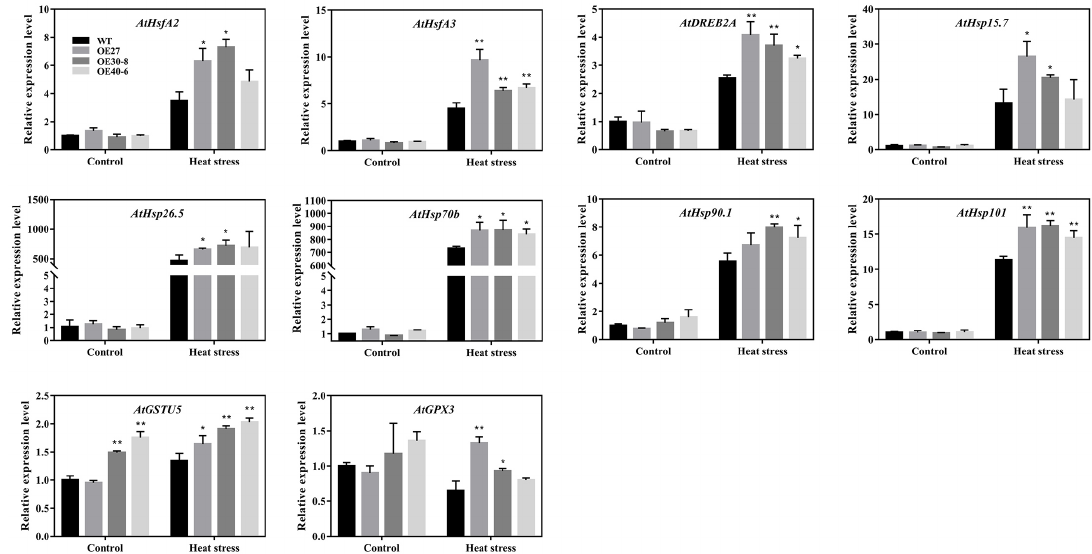
Figure 9. Expression of stress-related genes in Arabidopsis . The gene expression levels of 12-day-old Arabidopsis seedlings treated under 37 ◦ C for 0 or 2 h were detected by qRT-PCR. All primers are shown in Table S1. Data are means ± SD of three biological replicates. The asterisks on the top of bars indicate significant differences between CaHsfA1d transgenic and WT plants. * p < 0.05, ** p < 0.01 by t -test. AtHsfA2 (At2G26150), AtHsfA3 (At5G03720), AtDREB2A (At5g05410), AtHsp15.7 (At5G37670), AtHsp26.5 (At1G52560), AtHsp70b (At1G16030), AtHsp90.1 (At5G52640), AtHsp101 (At1G74310), AtGSTU5 (At2G29450), AtGPX3